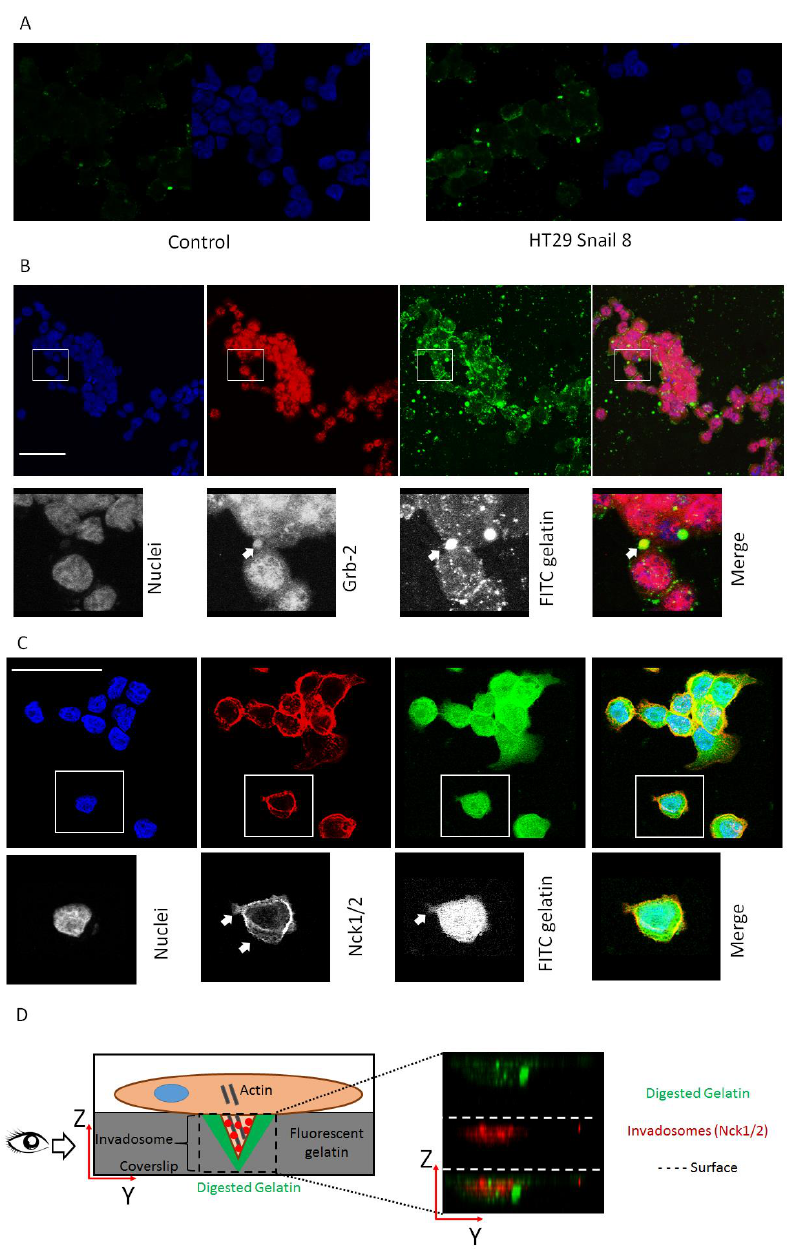
Figure 2. Invadosome structures formed in HT-29 cells overexpressing Snail. ( A ) The increased proteolysis of FITC-DQ gelatine (green) triggered by HT-29/Snail cells (right panel) compared to control cells (left panel) were visualized by confocal microscopy. The nuclei were stained with Hoechst 33342 (blue). Cellular localization of invadosome related protein Grb-2 ( B ) and Nck1/2 ( C , D ) were visualized by confocal microscopy. ( B ) Arrows point accumulation of Grb-2 (red) with FITC-gelatine degradation spots (green). Nck1/2 co-localization with gelatine degradation was observed on both: focal-XY axis ( C ) and ventricle side of the cells—as shown on YZ axis ( D , right panel). The cartoon visualization of Nck1/2 localization in cell ( D , left panel). Bars indicate 50 µm.